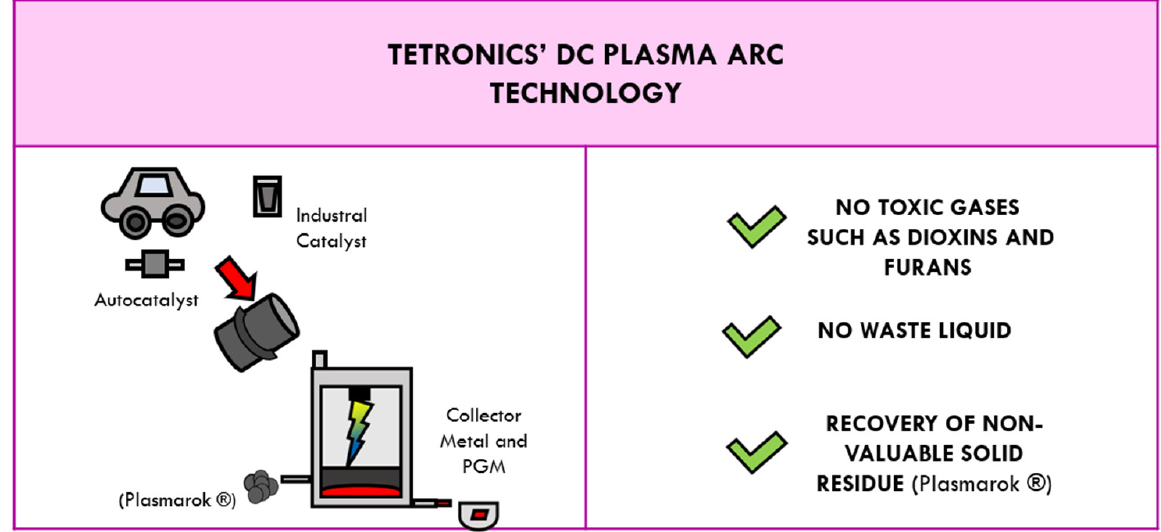
Figure 7. Main advantages of tetronic’s DC plasma arc technology.